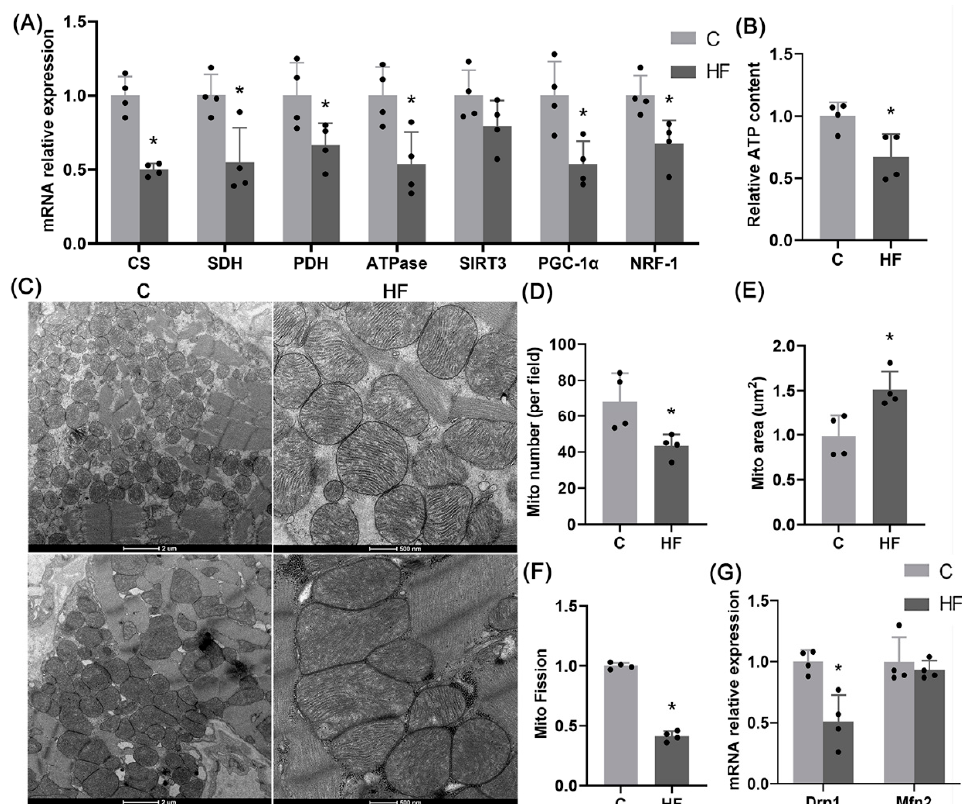
Figure 2. Mitochondrial dysfunctions in hypertension-induced HFpEF. ( A ) mRNA expression of mitochondrial function-related genes CS, SDH, PDH, ATPase, SIRT3, PGC-1 α , NRF-1 in the LV; n = 4 per group. ( B ) Relative ATP content in the LV (normalized using protein concentration); n = 4 per group. ( C – F ) Representative images of mitochondrial transmission electron microscopy in the LV (Scale bar: 2 µ m, 500 nm) ( C ), quantitative analysis of the number of mitochondria per unit field of view (analysis of more than 100 mitochondria per sample, 4 samples per group) ( D ), quantitative analysis of mitochondrial area (analysis of more than 100 mitochondria per sample, 4 samples per group) ( E ), and quantitative analysis of mitochondrial fission index (ratio of mitochondrial number to mitochondrial area, n = 4 per group) ( F ). ( G ) mRNA expression of Drp1, a key gene for mitochondrial fission in the left ventricle of rats, and Mfn2, a key gene for mitochondrial fusion ( n = 4 in each group). The data are mean ± SD, * Compared with the C group, p < 0.05.